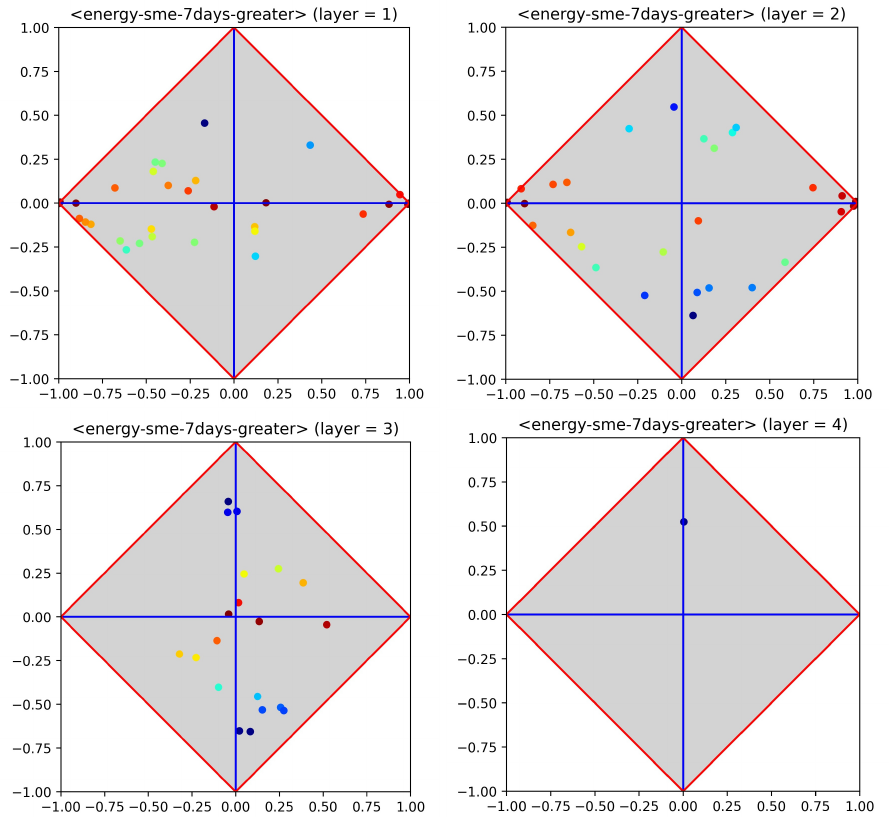
Figure 5. Hidden layers of an MLP trained on the dataset relating to enterprise customers (full set of features). The focus was on predicting whether the next-hour load would be greater than the previous